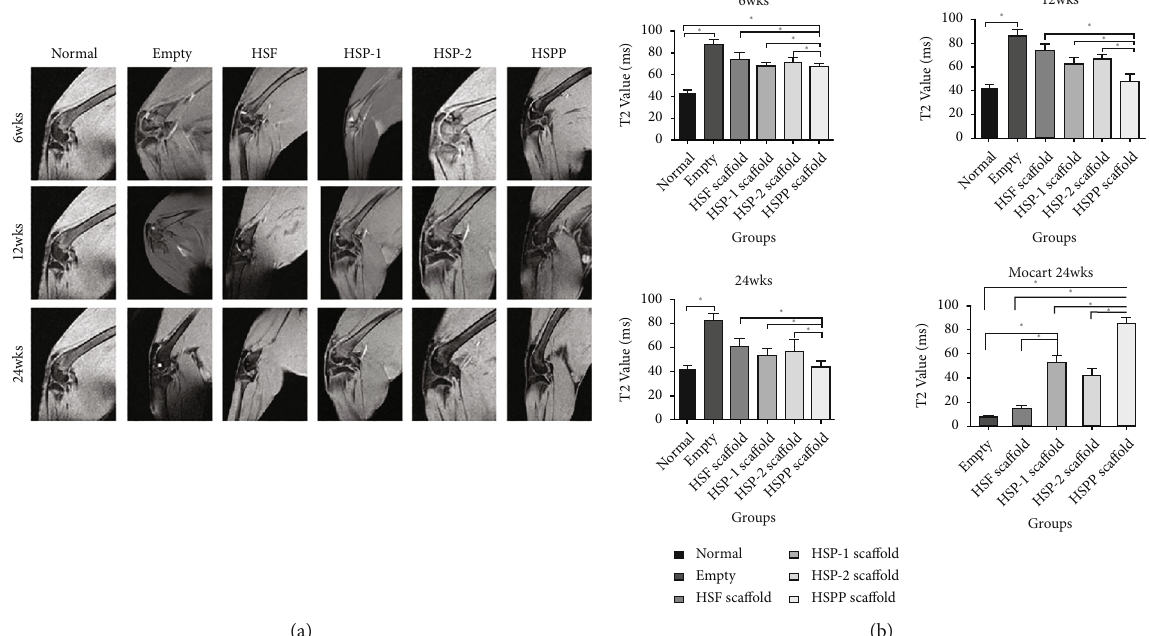
Figure 8: (a) MRI images of osteochondral defect regeneration in di ff erent groups at set time points and (b) their T2 value and MOCART scores of each group at 24 weeks.